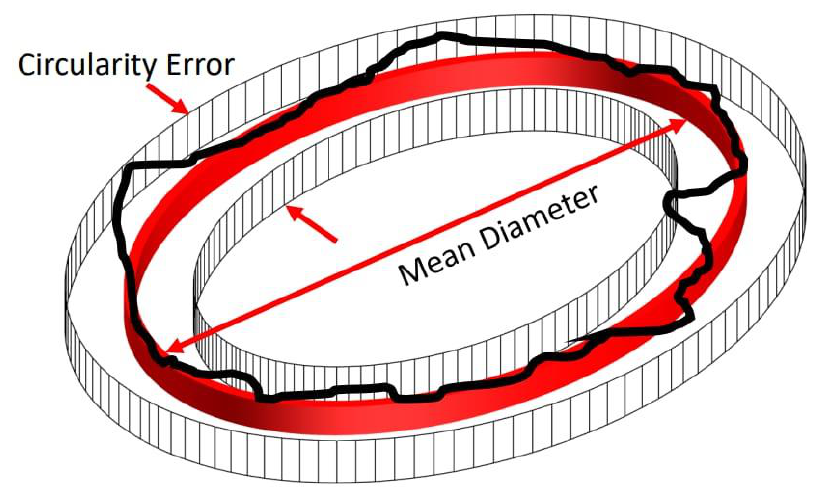
Figure 6. Circularity error.